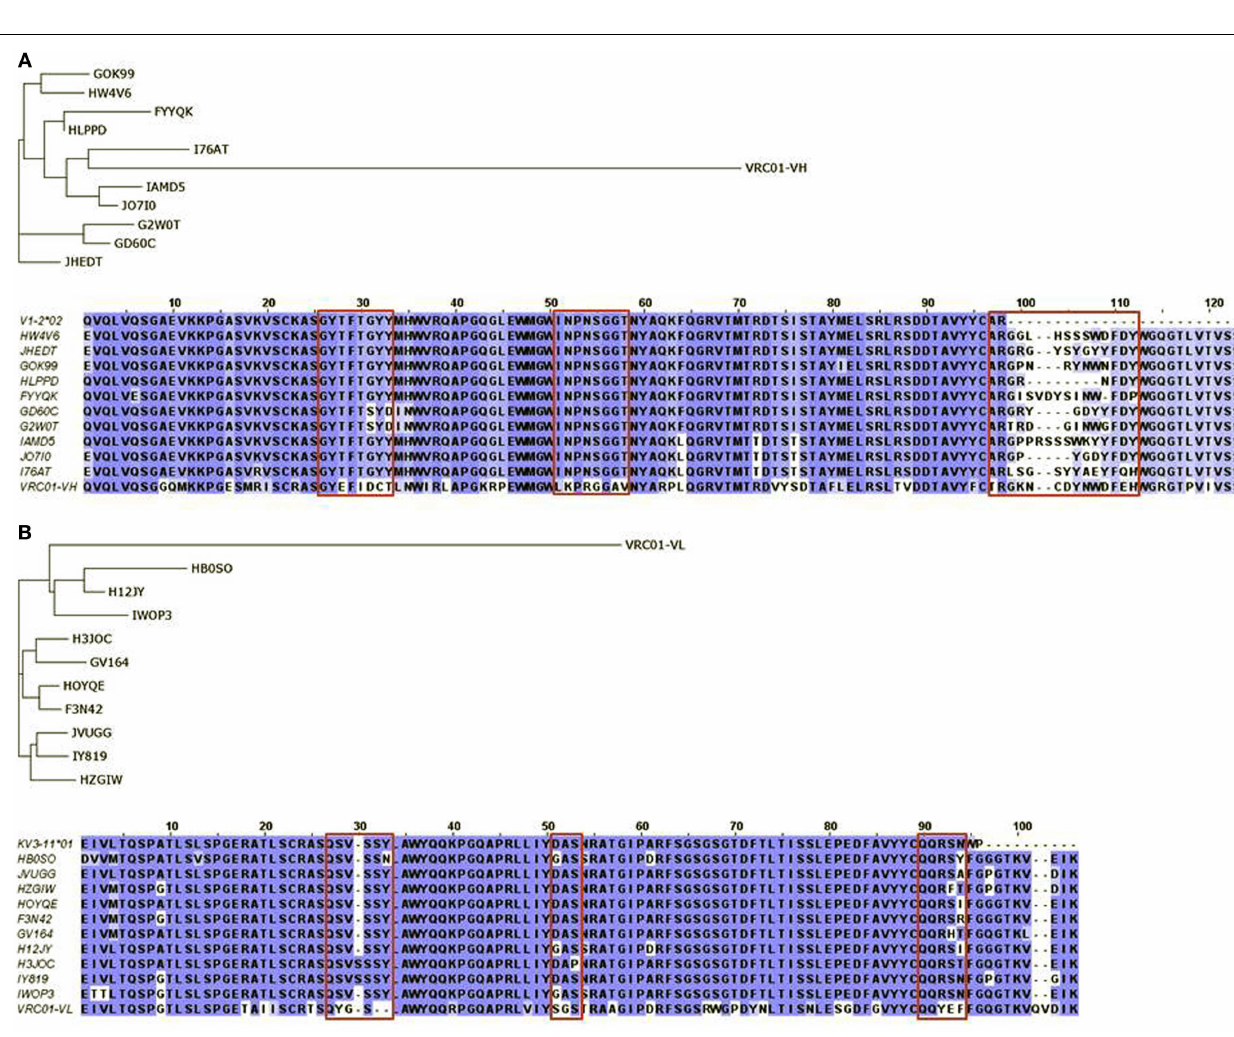
FIGURE 2 | Phylogram and sequence alignment of selected (A) heavy and (B) light chain sequences found in human cord blood IgM libraries of IGHV1-2 and IGKV3-11 lineages, respectively . Phylogenetic trees constructed using the amino acid sequences of top 10 putative germline-like precursors as found in the cord blood library along with mature heavy and